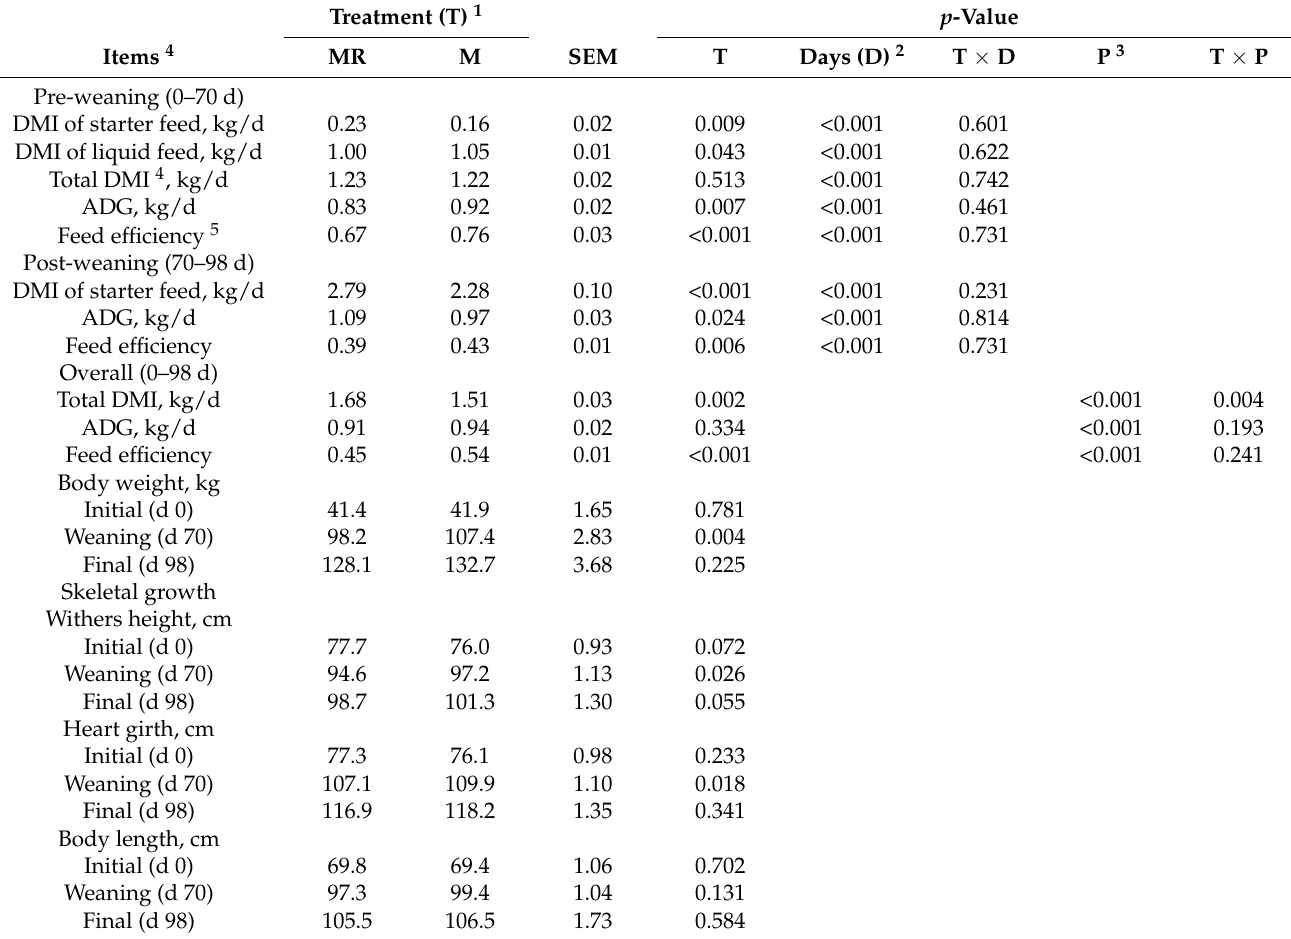
Table 2. Growth performance of calves fed milk or milk replacer. ( N = 14 per